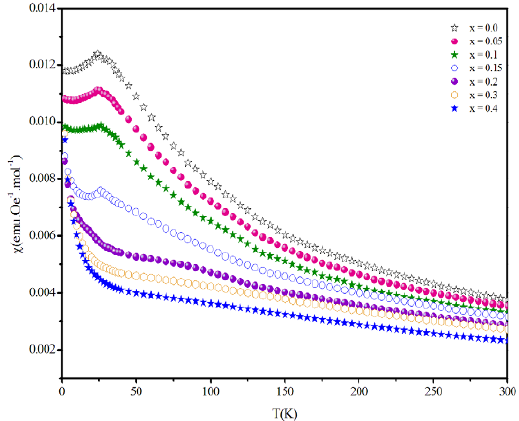
Figure 6. The variation of the Curie–Weiss parameters with the Al concentration